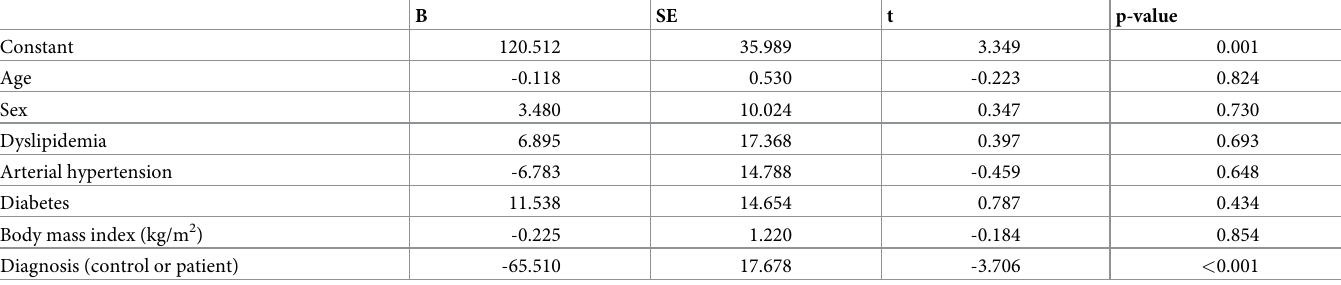
Table 4. Multiple regression analysis of the combined effect of clinical and demographic characteristics on serum paraoxonase-1